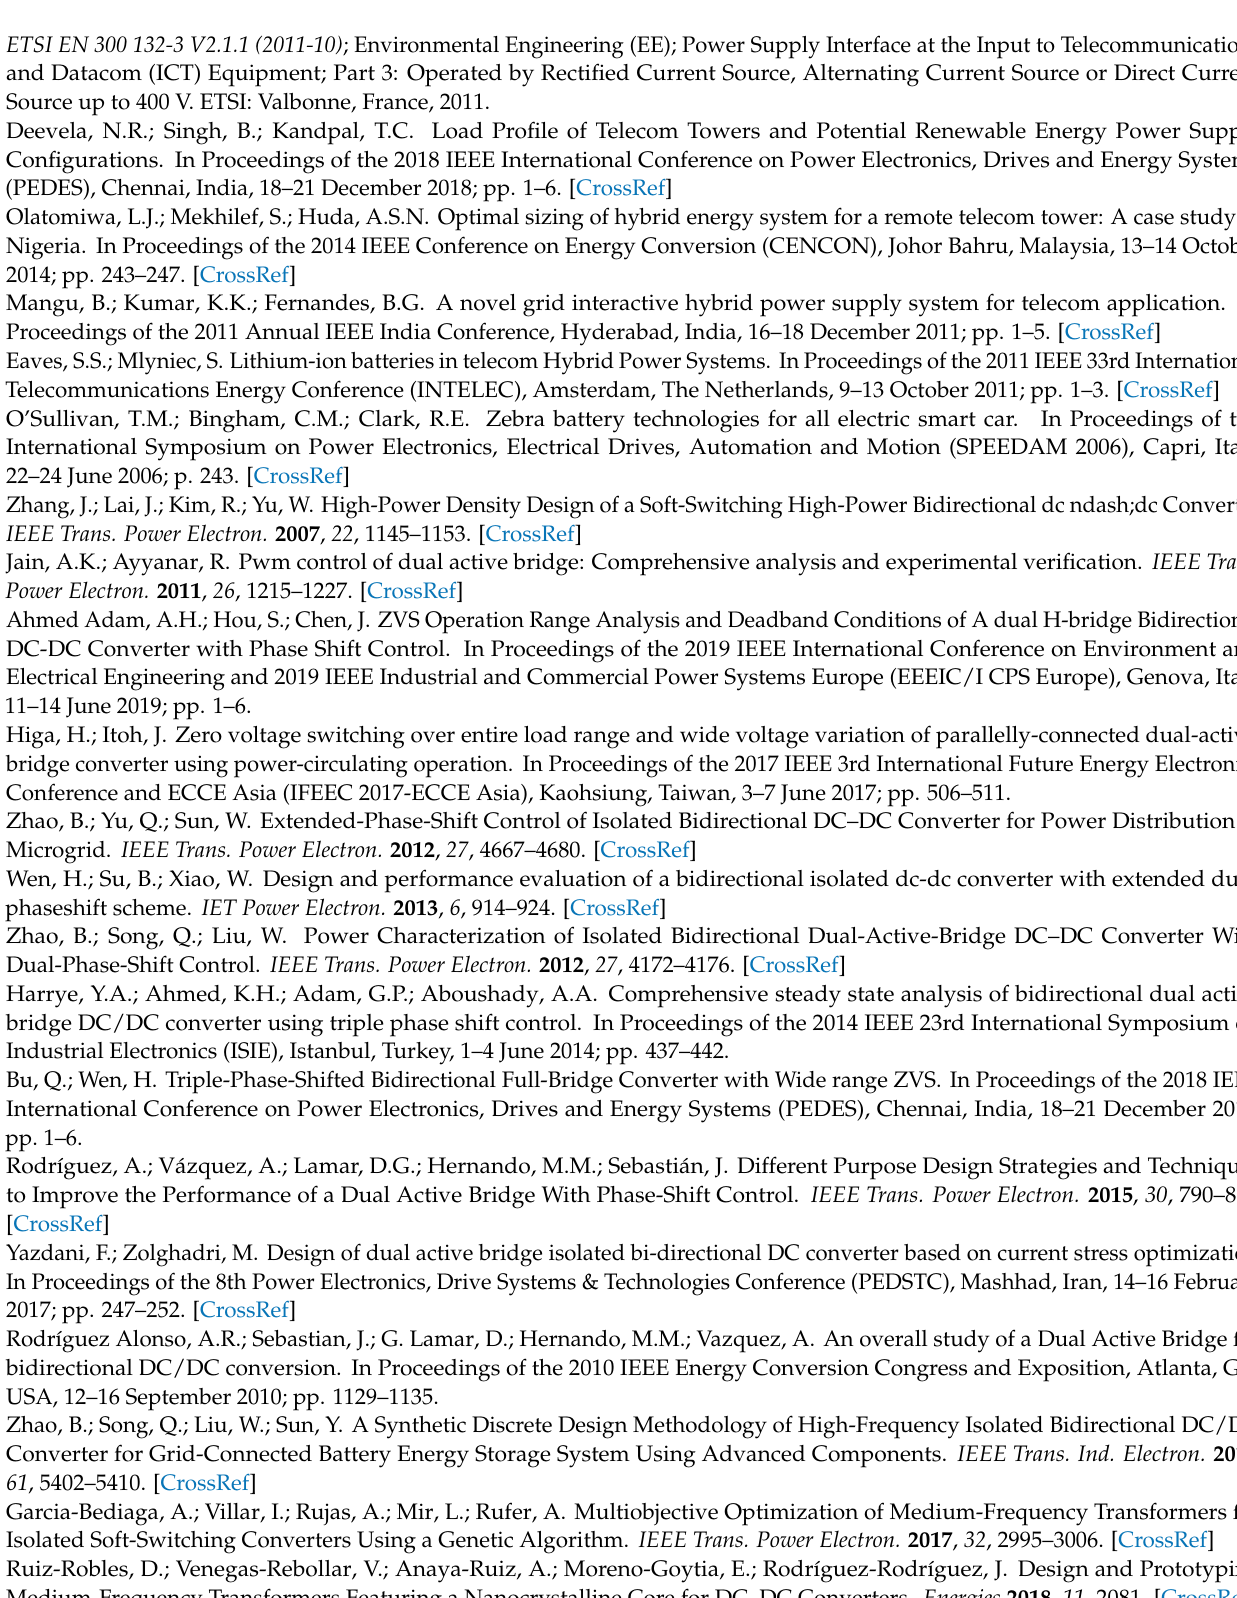
and Datacom (ICT) Equipment; Part 3: Operated by Rectified Current Source, Alternating Current Source or Direct Current Source up to 400 V. ETSI: Valbonne, France,